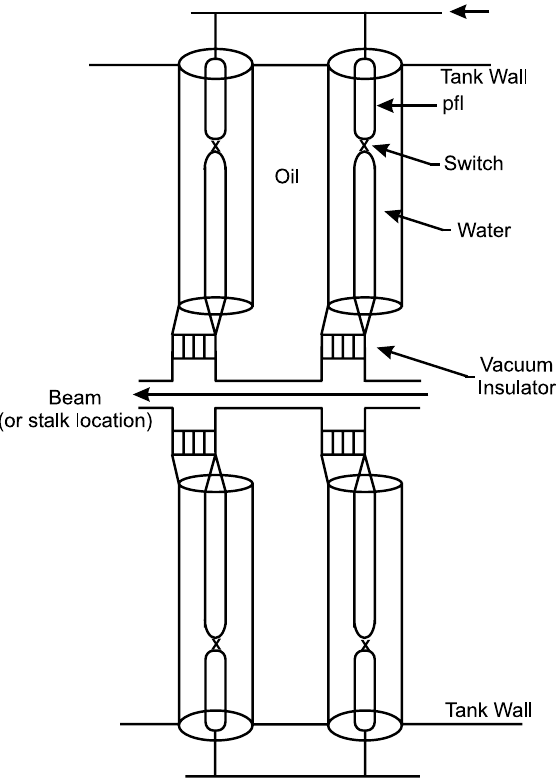
FIG. 5. Schematic of unipolar LIA (or IVA) using coax pfls in an inductive